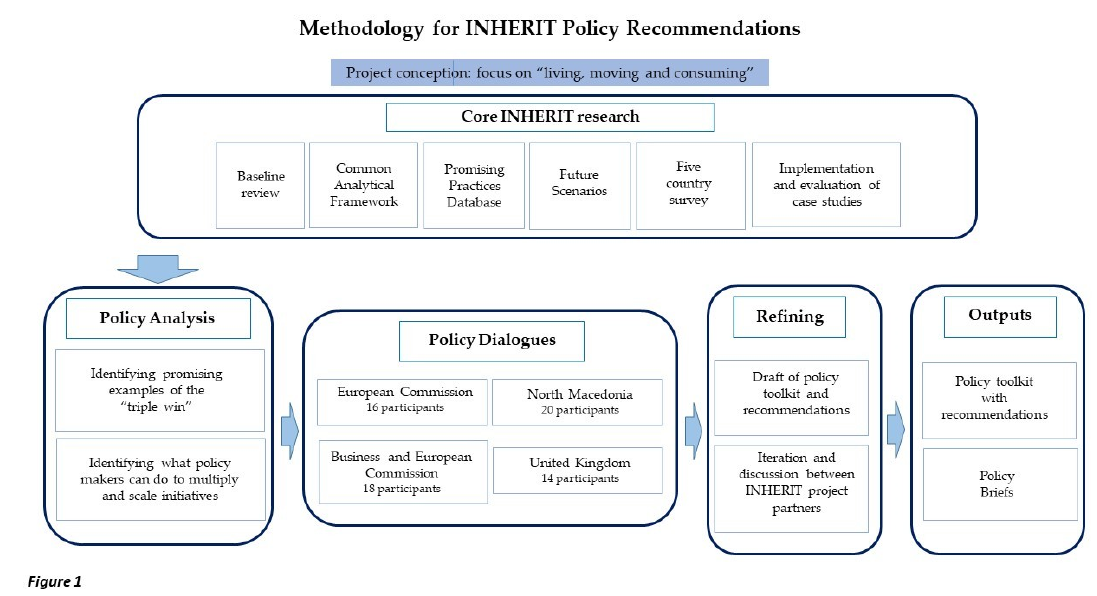
Figure 1. Methodology for INHERIT Policy Recommendations.